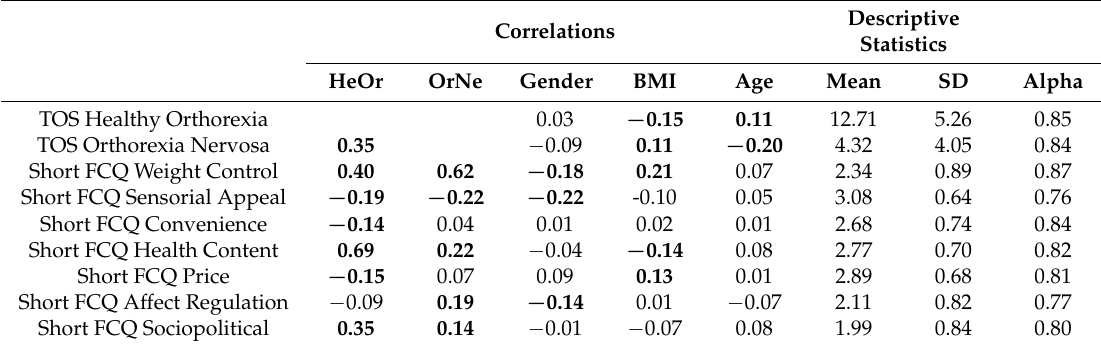
Table 3. Correlations and descriptive statistics of TOS and FCQ.